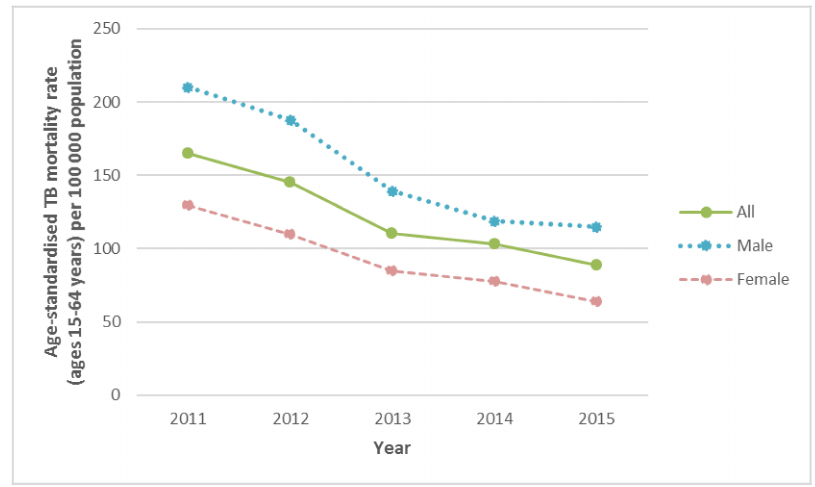
Figure 1. Age-standardised TB mortality rate (ages 15–64 years) per 100,000 population, overall and by sex.